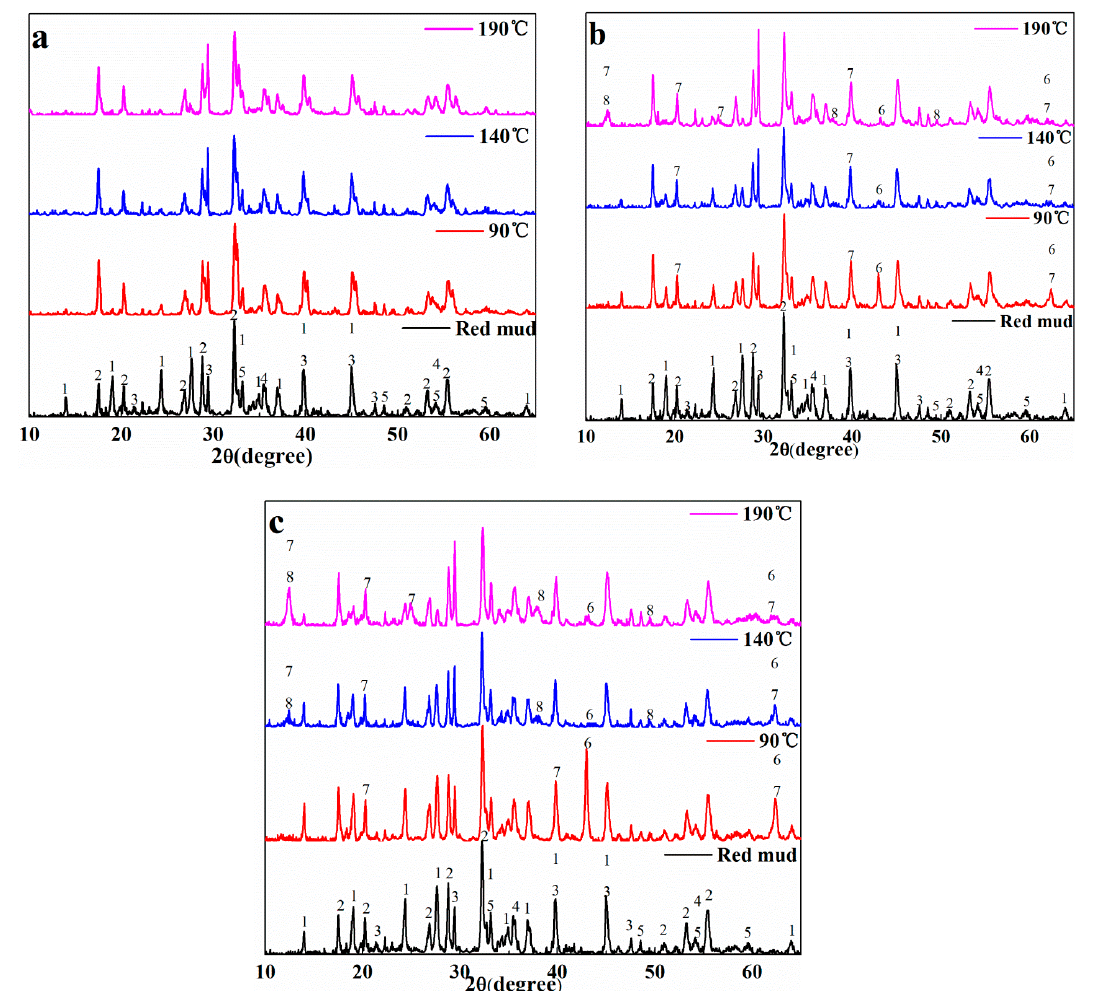
Figure 5. XRD patterns of solid products at temperatures <200 °C: ( a ) 0% MgO addition; ( b ) 50% MgO addition; ( c ) 100% MgO addition (1—Na 8 Si 6 Al 6 O 24 (H 0.88 (CO 3 ) 1.44 )(H 2 O) 2 ; 2—Ca 2.93 Al 1.97 Si 0.64 O 2.56 (OH) 9.44 ; 3—CaCO 3 ; 4—Fe 2 O 3 ; 5—CaTiO 3 ; 6—MgO; 7—Mg(OH) 2 ; 8— (Mg 4.5 Al 1.5 )(Si 2.5 Al 1.5 )O 10 (OH) 8 ); % means the mole fraction of MgO addition; only new phases are marked out while the same XRD pattern for the red mud is presented without labels in each figure for Table 2. XRD patterns of solid products at temperatures <200 °C.